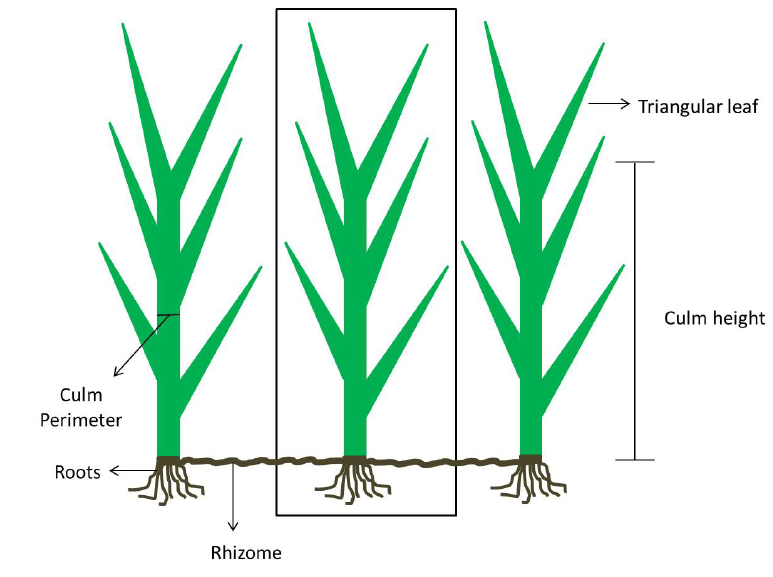
Figure 2. Scheme showing the emergent aquatic macrophyte S. alterniflora forming